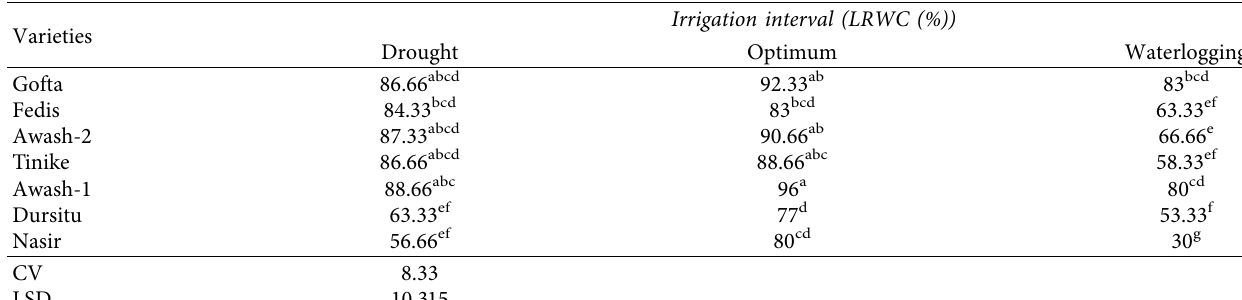
Table 3: Interaction efects of common bean varieties and soil irrigation interval on leaf relative water content (LRWC) under lath house, from June to September, 2020.